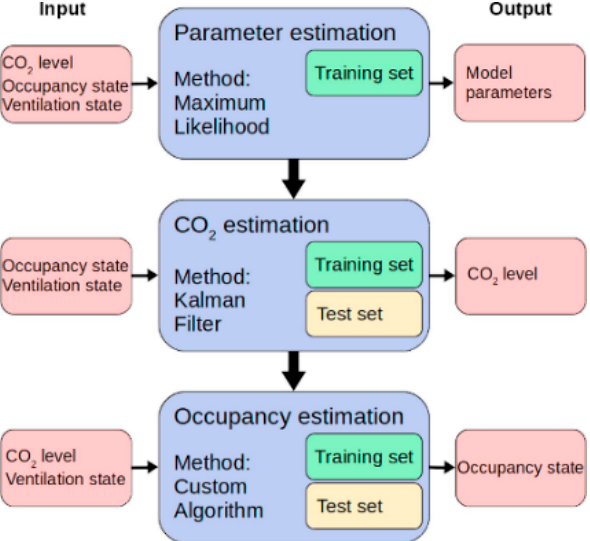
Figure 6. Workflow to estimate occupancy state based on CO 2 level [103].